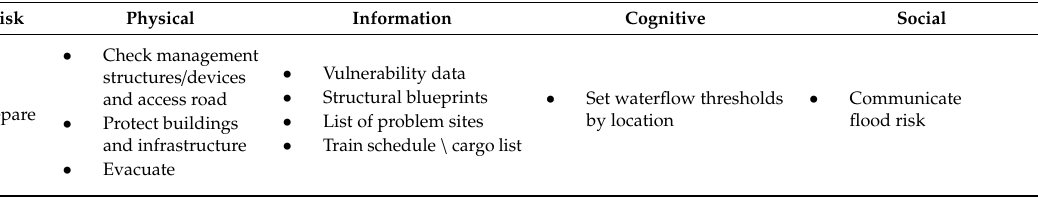
Table 2. Risk reduction strategies (adapted by authors from Fox-Lent et al.